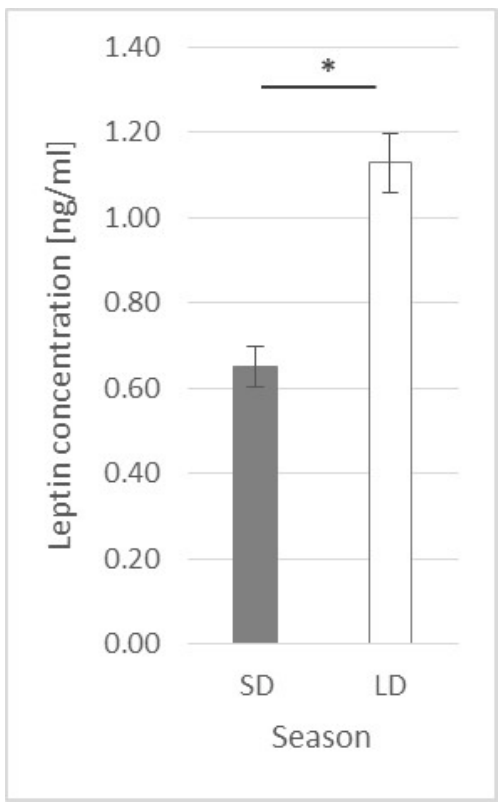
Figure 1. Plasma leptin concentration—comparison between short-day (SD) and long-day (LD) seasons at a 0 h time point; *—indicates p ≤ 0.05, according to Student’s t -test ( n = 24). This was also observed at each time point when the control groups were compared (Figure 2A). In comparison to a 0 h time point, LPS injection increased leptin concentration at 2.5 h and 3 h time points in the SD season or only after 3 h from injection in the LD season (Figure 2B). The leptin injection at a 0.5 h time point caused a rapid increase in plasma leptin concentration regardless of the season, and at 1 h time point, the highest leptin concentrations were observed as 18.20 ± 1.01 and 21.68 ± 1.05 ng/mL for the SD and LD seasons, respectively (Figure 2C). Starting from that moment, the concentration of leptin was systematically falling to the final level of 8.49 ± 0.73 and 10.28 ± 0.30 ng/mL for the SD and LD seasons, respectively; however, at each time point, the leptin concentration was higher in the LD season than that in the SD season. When leptin was injected after LPS, a rapid increase in leptin concentration was also observed, followed by a systematic decrease (Figure